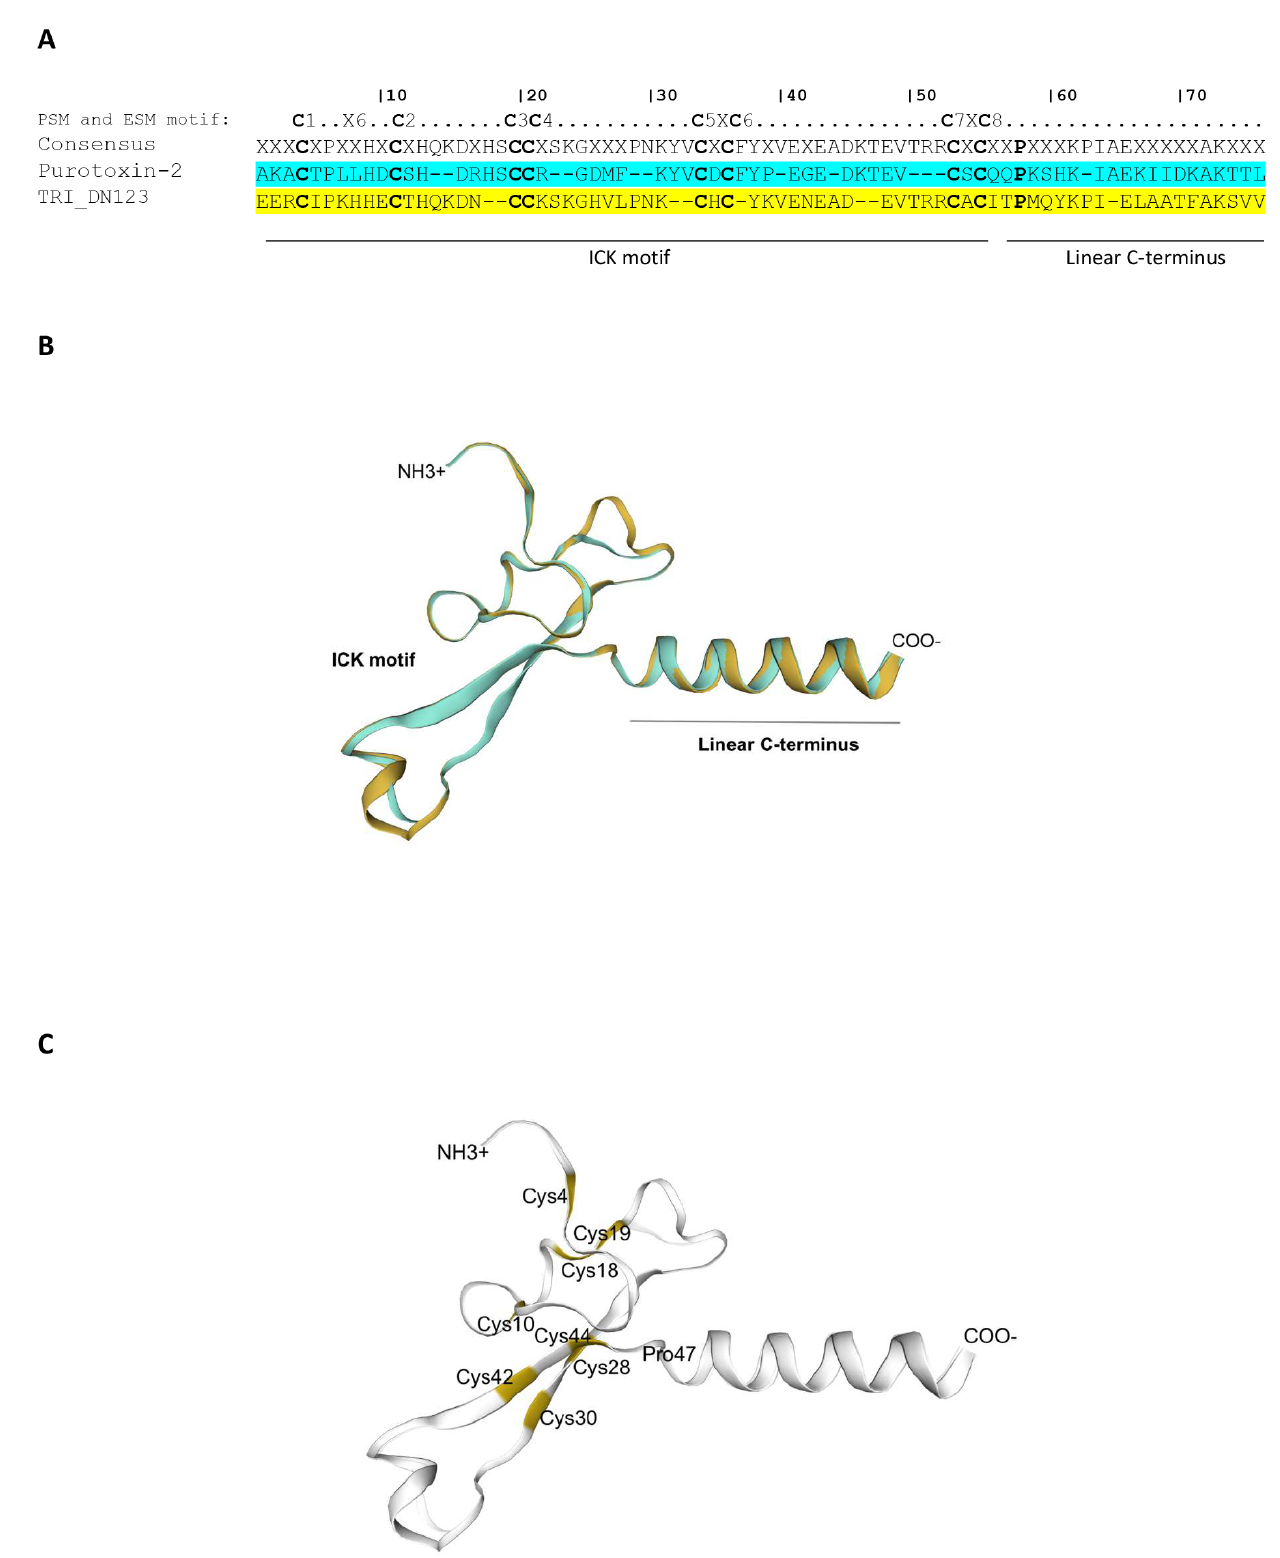
Figure 7. Sequence alignment of toxin-like PpenTox1 and 3D model. (A) PpenTox1 sequence (transcript TRINITY_DN123_c0_gl_i2) was aligned with purotoxin-2 as template (PDB ID: ID:2MZF). (B, C) Three-dimensional model was generated using SWISS-MODEL. The color aqua green represents purotoxin-2, while yellow corresponds to PpenTox1. Cys residues are in bold font (panel A ) and are indicated in panel C . Cys-rich ICK motif and linear C-terminal are indicated in the alignment and 3D